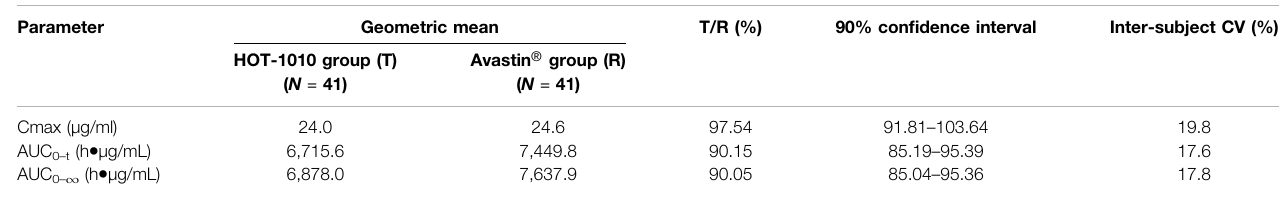
TABLE 3 | Statistical comparison of primary pharmacokinetic parameters of bevacizumab.